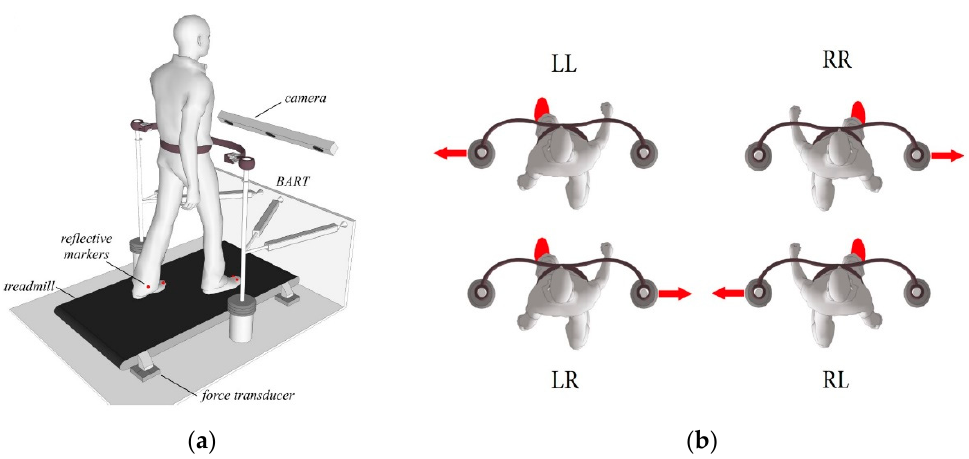
Figure 1. The experimental setup and perturbation directions. ( a ) A graphical illustration of the experimental setup. Subjects walked on an instrumented treadmill while receiving pelvic perturbations induced by the BART device. ( b ) A top-view illustration of the perturbation directions. Outward perturbations LL/RR: perturbation to the left/right triggered at left/right foot contact; inward perturbations LR/RL: perturbation to the right/left triggered at left/right foot contact.